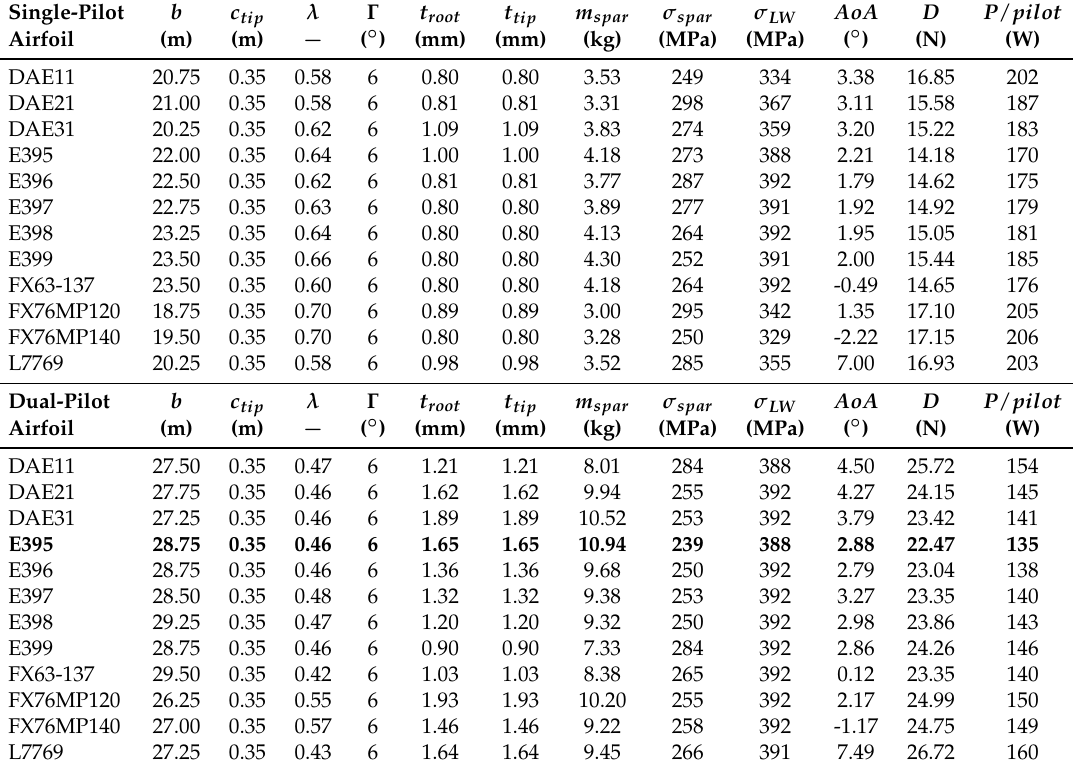
Table 8. Geometrical and structural data of optimal designs (upper table: single-pilot; lower table: dual-pilot). The line in bold indicates the design which requires the lowest power per